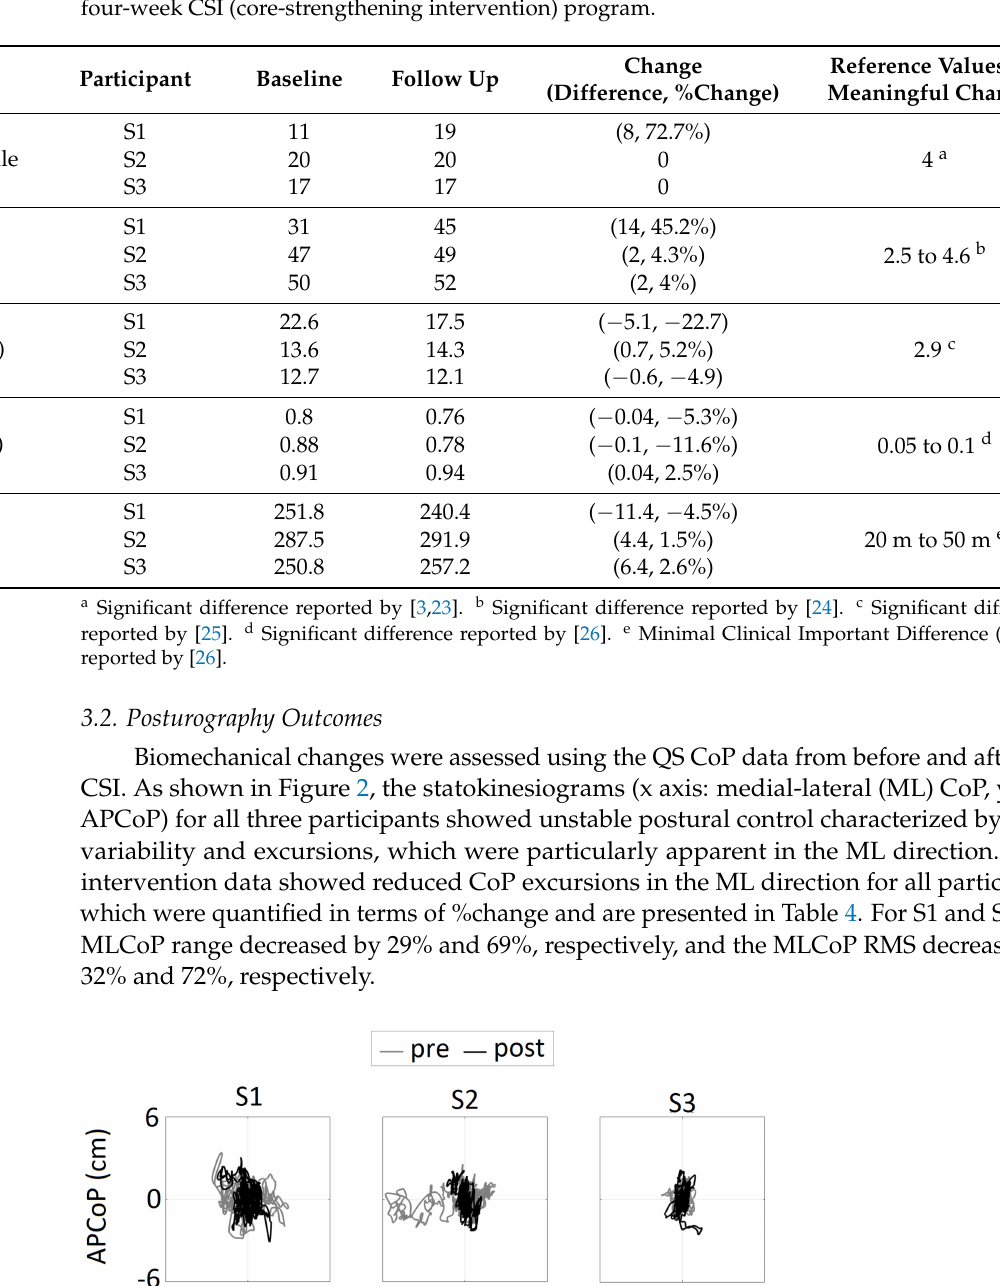
Table 3. Changes in functional clinical outcomes for three stroke participants after the completion of four-week CSI (core-strengthening intervention) program.